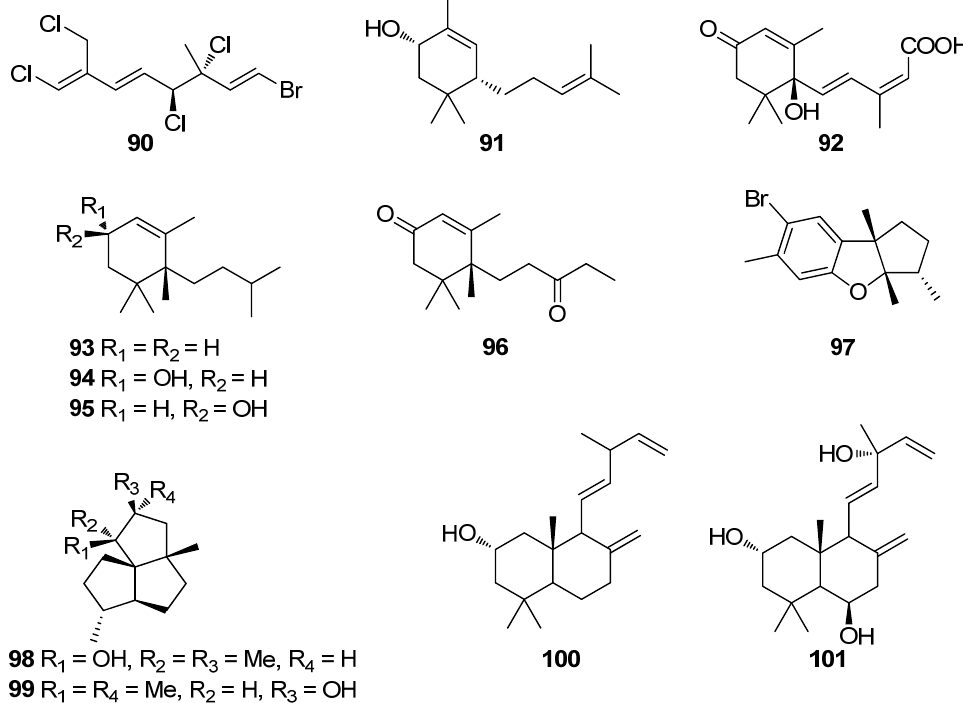
Figure 9. Chemical structures of compounds 90 – 101 .